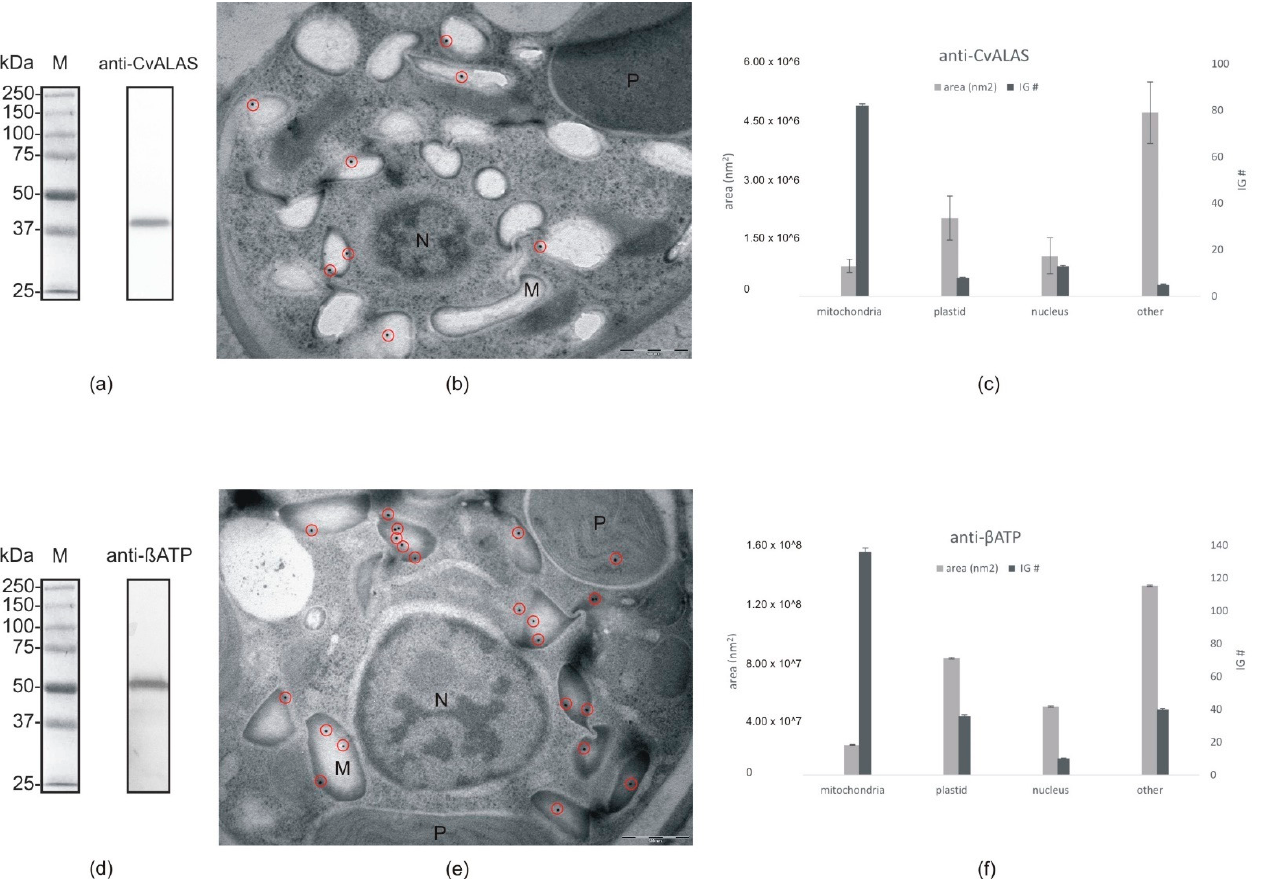
Figure 7. Immunogold labeling: ( a ) Western blot with anti-CvALAS on total protein extract from C. velia ( b ) Micrograph of C. velia ultrathin section after immunogold labeling with specific anti-CvALAS as a primary antibody. The majority of gold particles (encircled) were detected in the mitochondria. ( c ) Distribution of secondary IG particles (detecting anti-CvALAS) among cell compartments counted from all 35 micrographs. ( d ) Western blot with anti- β ATP on total protein extract from C. velia ( e ) Micrograph of C. velia ultrathin section after immunogold labeling with specific anti- β ATP as a primary antibody. The majority of gold particles (encircled) were detected in C. velia mitochondria. ( f ) Distribution of secondary IG particles (detecting anti- β ATP) among cell compartments counted from all 35 micrographs. N = nucleus, M = mitochondria, P =